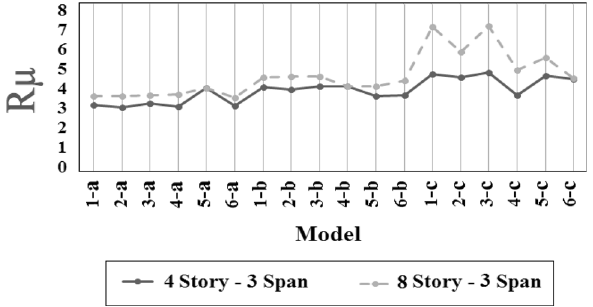
Fig. 14 The ductility coefficient of 4- and 8-story 2-span